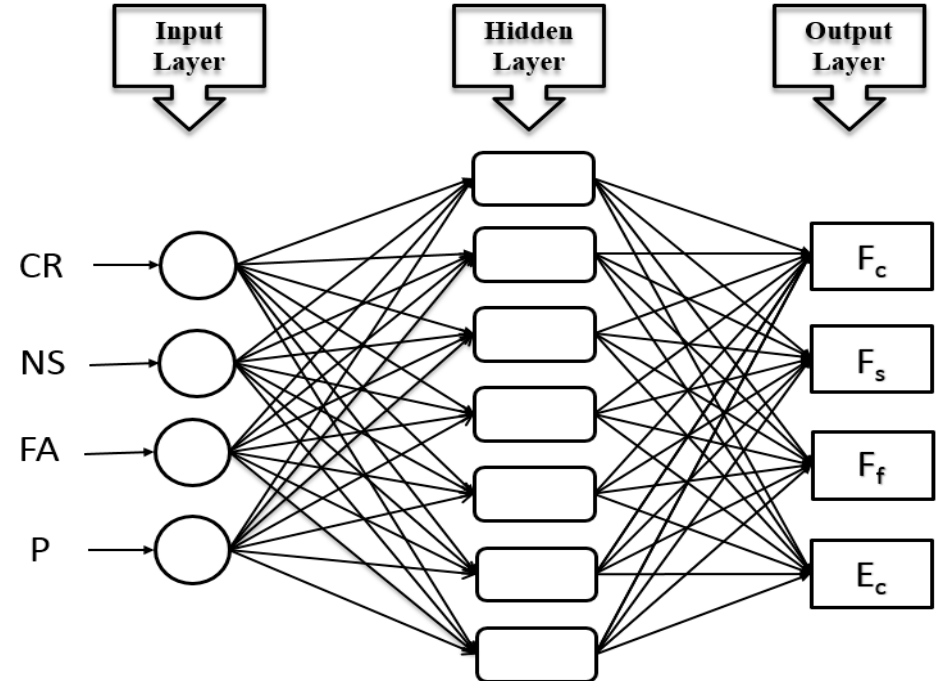
Figure 4. The MLP model’s configuration architecture.